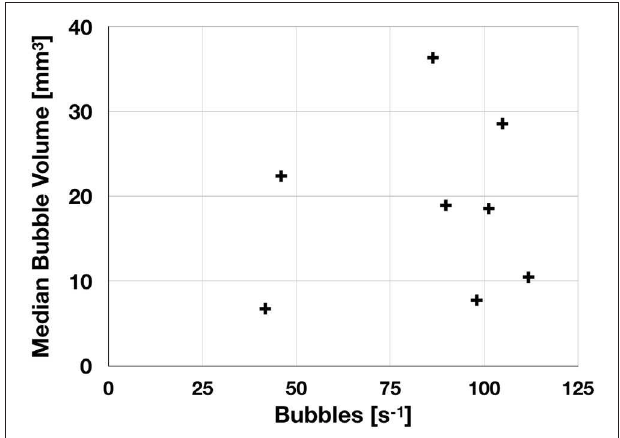
FIGURE 4 | Results of the bubble detection as executed on the SHiPCC unit onboard RV Poseidon cruise POS526. Shown are the recorded bubbles per second vs. the median bubble volume. Each data point represents one bubble stream. Individual streams were measured at different locations.